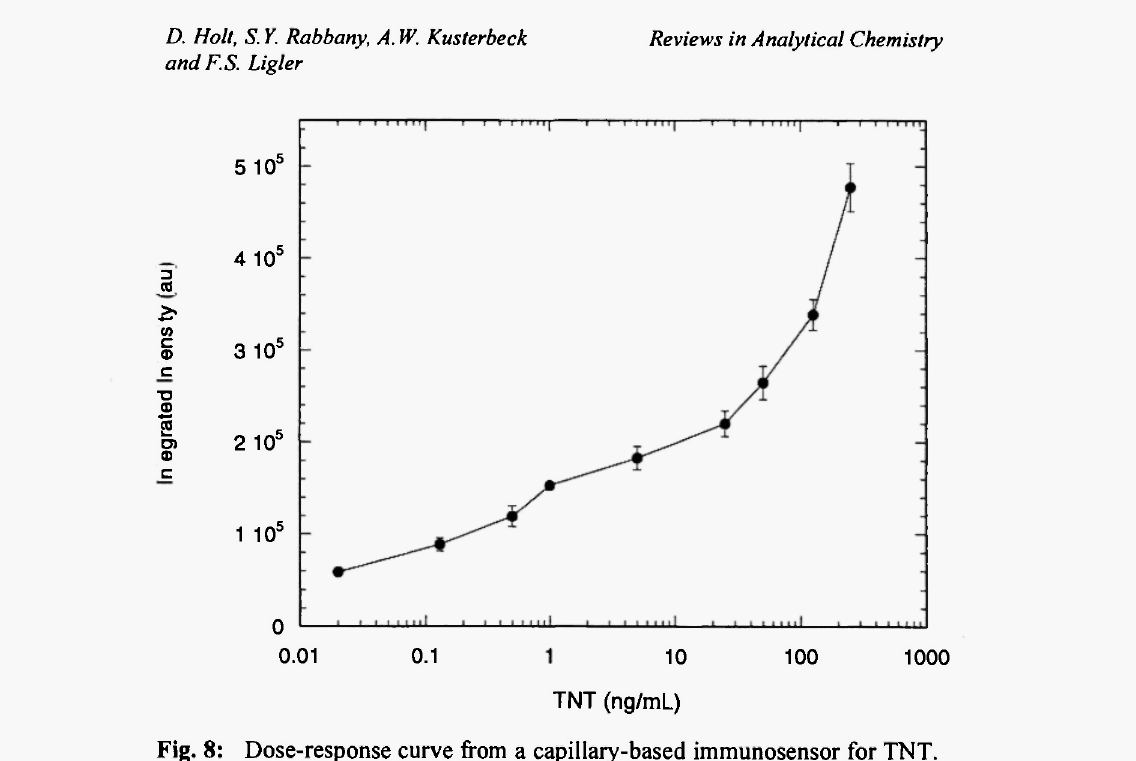
Fig. 8: Dose-response curve from a capillary-based immunosensor for TNT. 100 μί injections were made in triplicate. The data shown are the mean